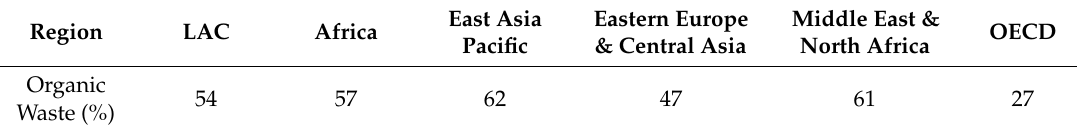
Table 1. Composition (%) of Organic Waste in LAC compared to other regions in the world